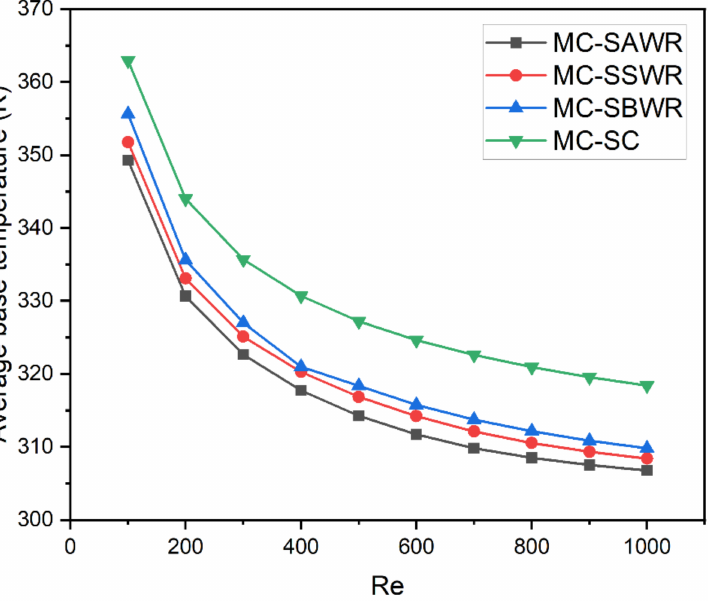
Figure 15. Variation of average base wall temperature ( T b ) with Re for various MCHS